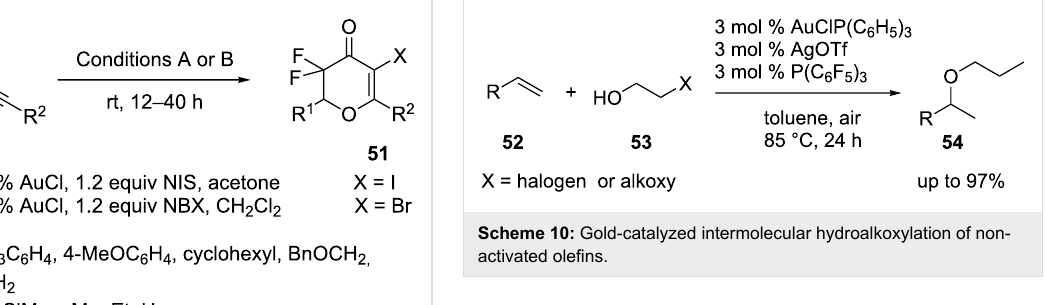
NaAuCl 4 . The benzylic and secondary alcohols ( 55 and 58